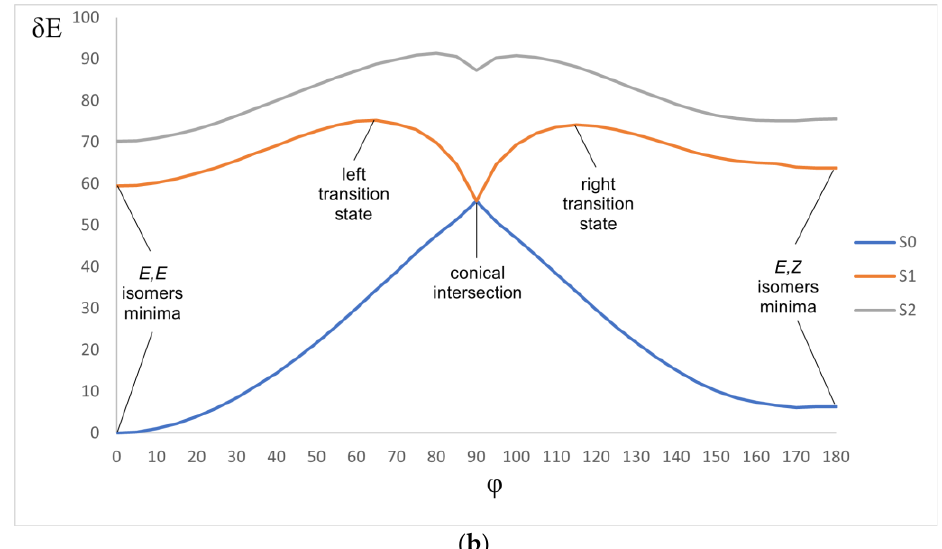
Figure 11. ( a ) Scheme of the photoisomerization mechanism. ( b ) Typical potential energy profile (kcal/mol) of the ground S0 and lowest excited π - π * and n - π * states. ϕ is the dihedral angle at the C=C bond.